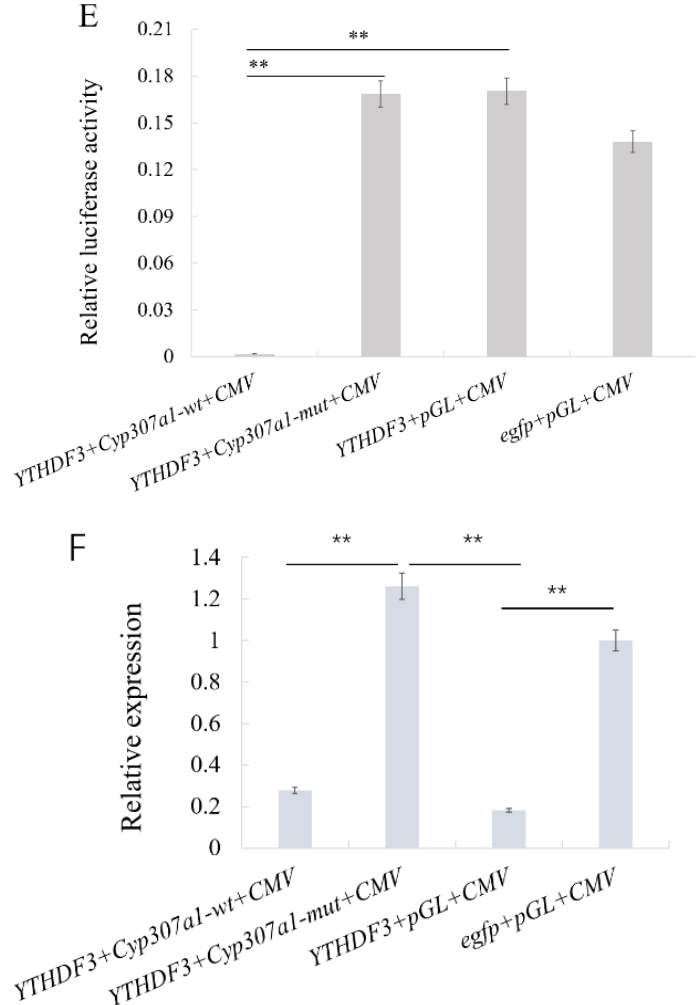
Figure 3. YTHDF3 mediates Cyp307a1 mRNA degradation in the ecdysone pathway. ( A ) Reducing Cyp307a1 mRNA half-life by overexpressing YTHDF3 in BmN cells. ( B ) Graphical representation of retrotranscription followed by PCR of the m 6 A site of Cyp307a1 and Cyp18a1 . ( C ) Relative quantifica- tion of the m 6 A levels of Cyp307a1 and Cyp18a1 in BmN cells. Relative RT-QPCR data correspond to the mean and standard error of three independent experiments. ( D ) Construction of the dual- luciferase reporter assay. ( E ) Relative firefly luciferase (Fluc) activity. ( F ) mRNA level of Cyp307a1 . Values are mean ± s.d. of n = 4 independent experiments. Two-tailed Student’s t -tests were used (** p <